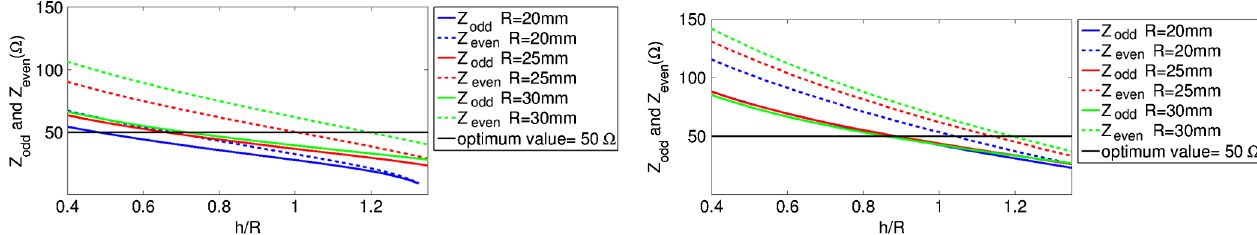
FIG. 7. Odd and even mode characteristic impedance versus h = R, for flat electrodes (left) and type (e) half-moon electrodes